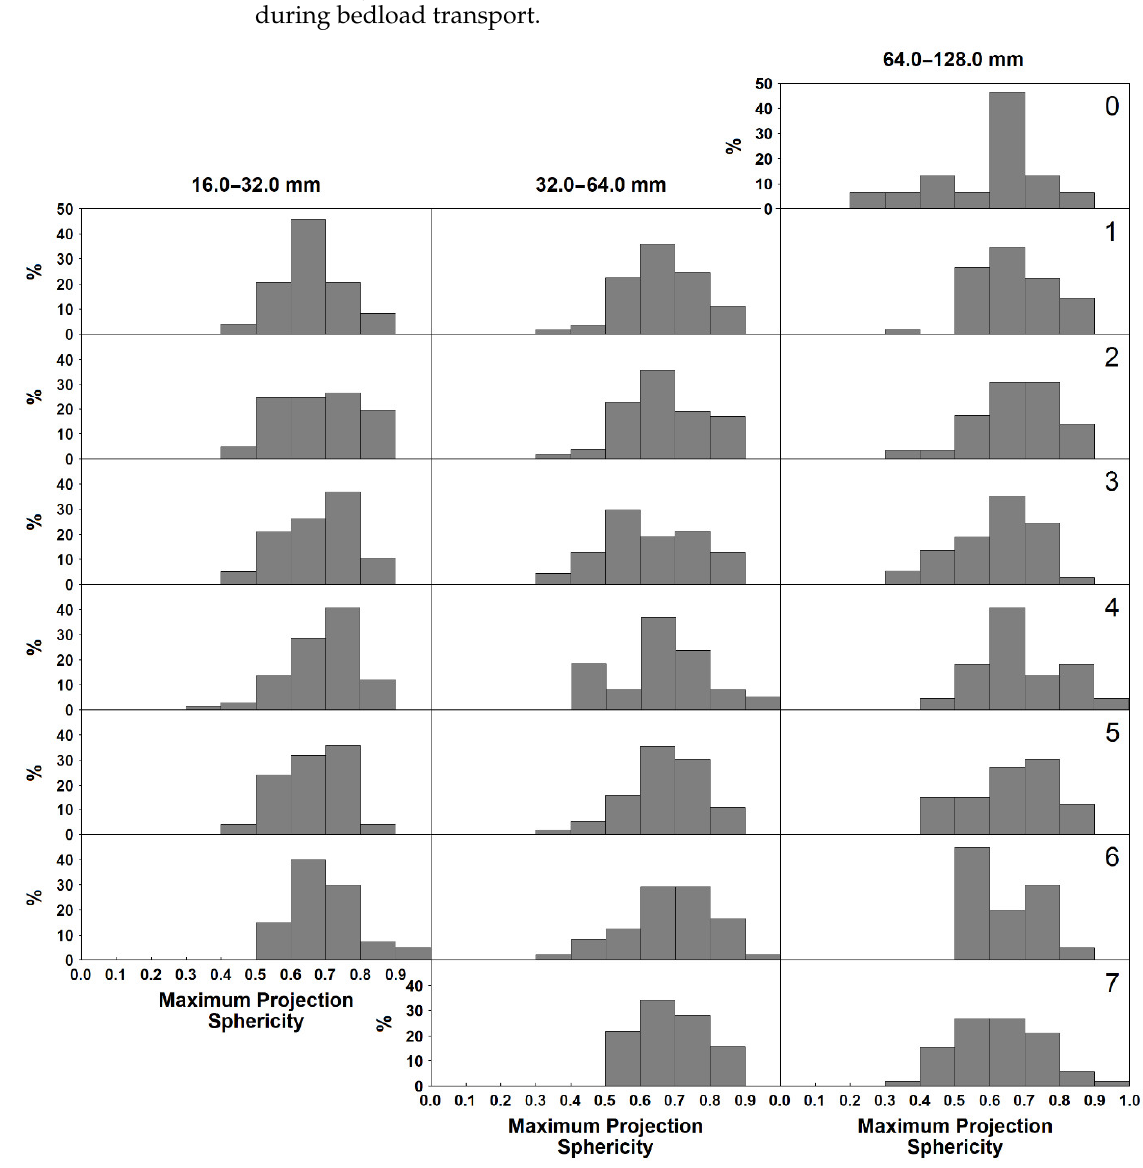
Figure 11. The frequency distribution of the Maximum Projection Sphericity of gravels of Navilawa Monzonite within the 16.0–32.0, 32.0–64.0 and 64.0–128.0 mm fractions from Stations 0–7 along the Sabeto River of western Viti Levu, Fiji.